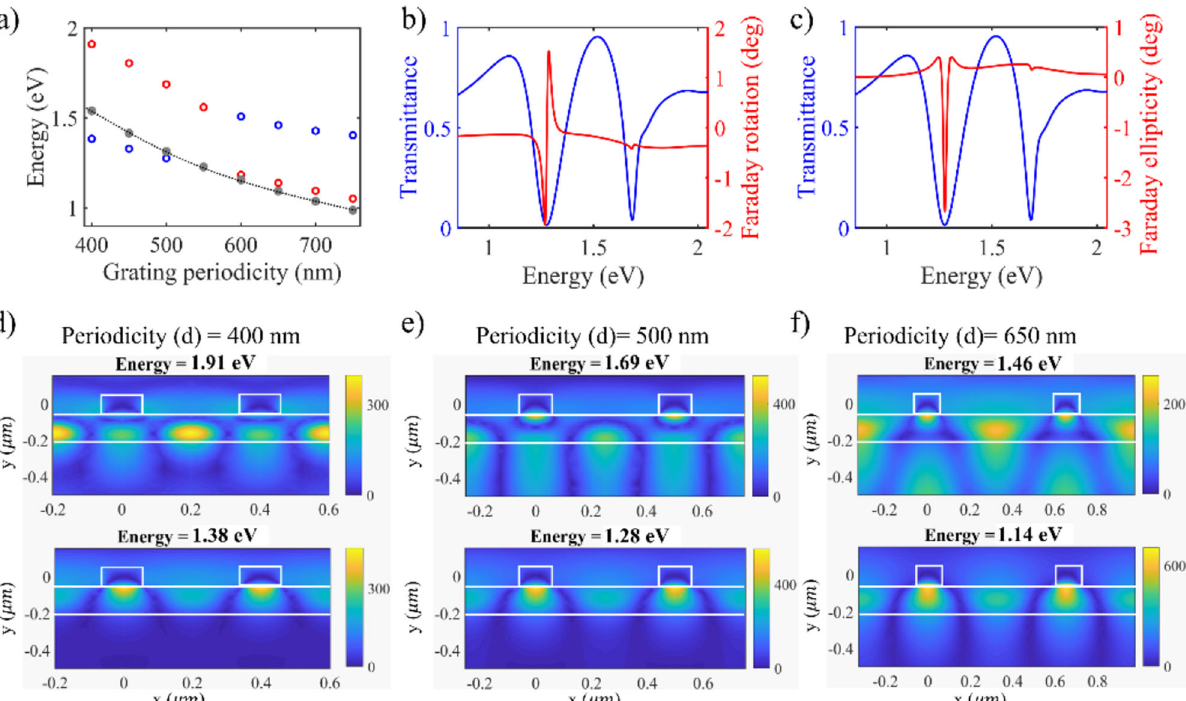
Fig. 5 Understanding the role of the waveguide-plasmon strong coupling and avoided crossing on enhanced Faraday effect in waveguide magneto- plasmonic crystal (WMPC) system with transverse magnetic (TM) polarized excitation. a The frequencies (energy E ¼ _ ω ) (here _ is the reduced Planck ’ s constant and ω is the frequency) corresponding to the spectral dips are shown as a function of varying value of periodicity d of the grating in the WMPC width and height fi xed at 120 and 100 nm, respectively. The dispersion of the transverse electric (TE) waveguide mode (black dotted line) is also shown for varying periodicities. The spectral variation ( E ¼ _ ω ¼ 0 : 83to2 : 067eV) of Faraday rotation ψ ( b , right axis, red solid line) and ellipticity ξ ( c , right axis, red solid line) for grating periodicity d = 500 nm within the window of the avoided crossing. The spectral variation of the transmitted TM polarized intensities are also shown (left axis, blue dashed line). The simulated spatial distribution of the magnetic fi eld ( H ) for input TM polarization ( H y ) at energies (frequencies) corresponding to the two transmission dips are shown for grating period d = 400nm (below the avoided crossing regime) ( d ), for d = 500 nm (at the avoi d ed crossing regime) ( e ), and for d = 650 nm above the avoided crossing ( f ). The cross section of the WMPC is shown by white solid lines, with the rectangles representing the position of the gold (Au)